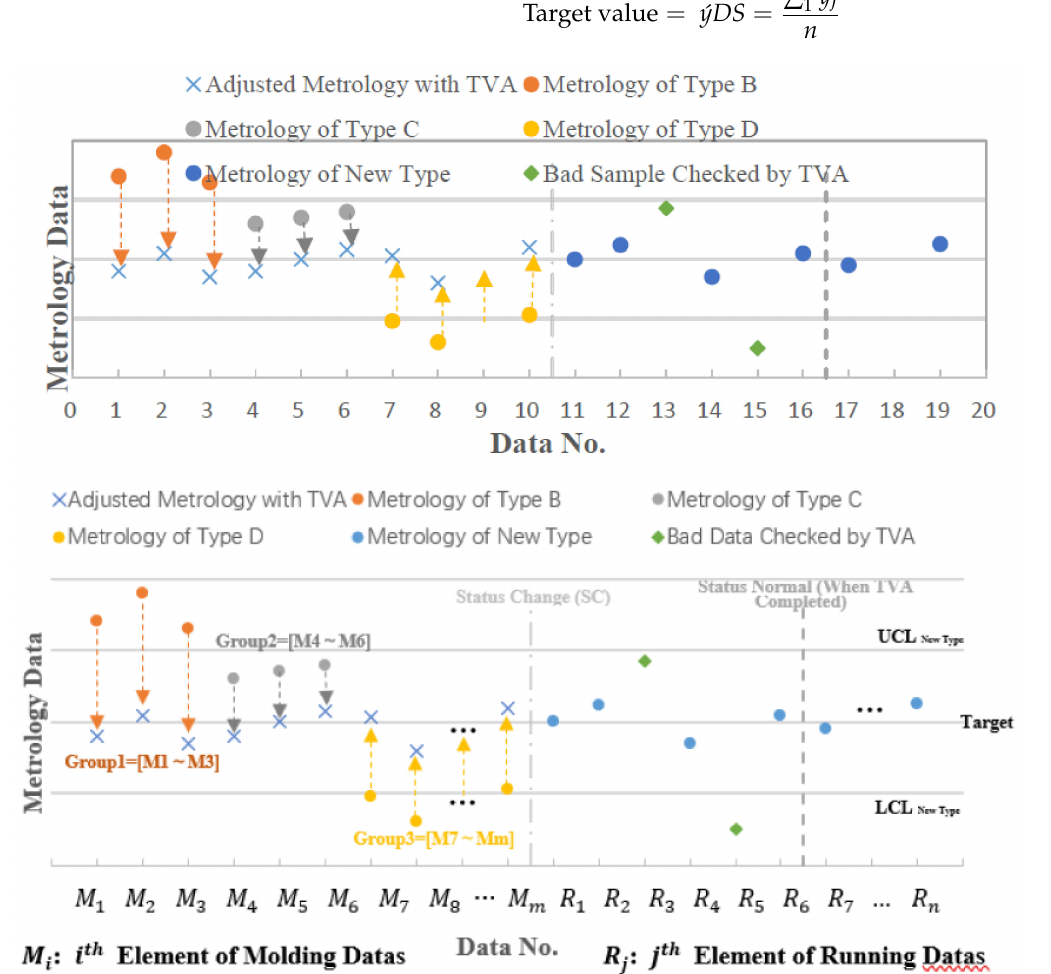
Figure 3. Operating scenarios of method and running data of the AVM